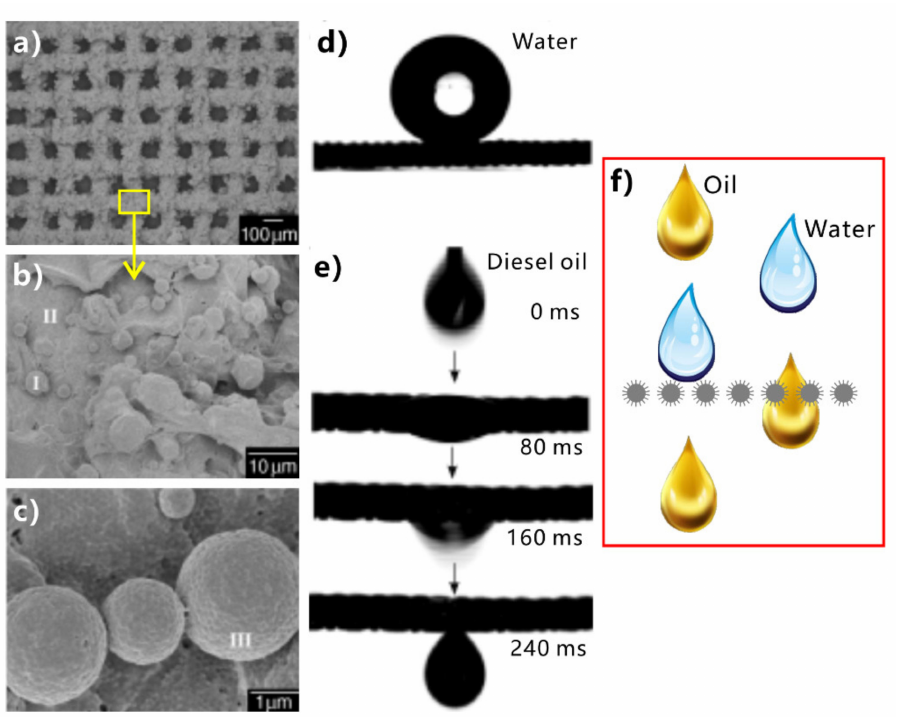
Figure 11. Separating the mixture of oil and water by using the superhydrophobic PTFE-coated stainless-steel mesh. ( a – c ) Surface morphology of the structured mesh. ( d ) Water droplet on the PTFE-coated mesh. ( e ) Process of oil droplets permeating through the resultant mesh. ( f ) Schematic separation mechanism for the oil/water mixture by the superhydrophobic and superoleophilic porous mesh. Reprinted with permission from ref. [61]. Copyright 2004, WILEY-VCH Verlag GmbH & Co.